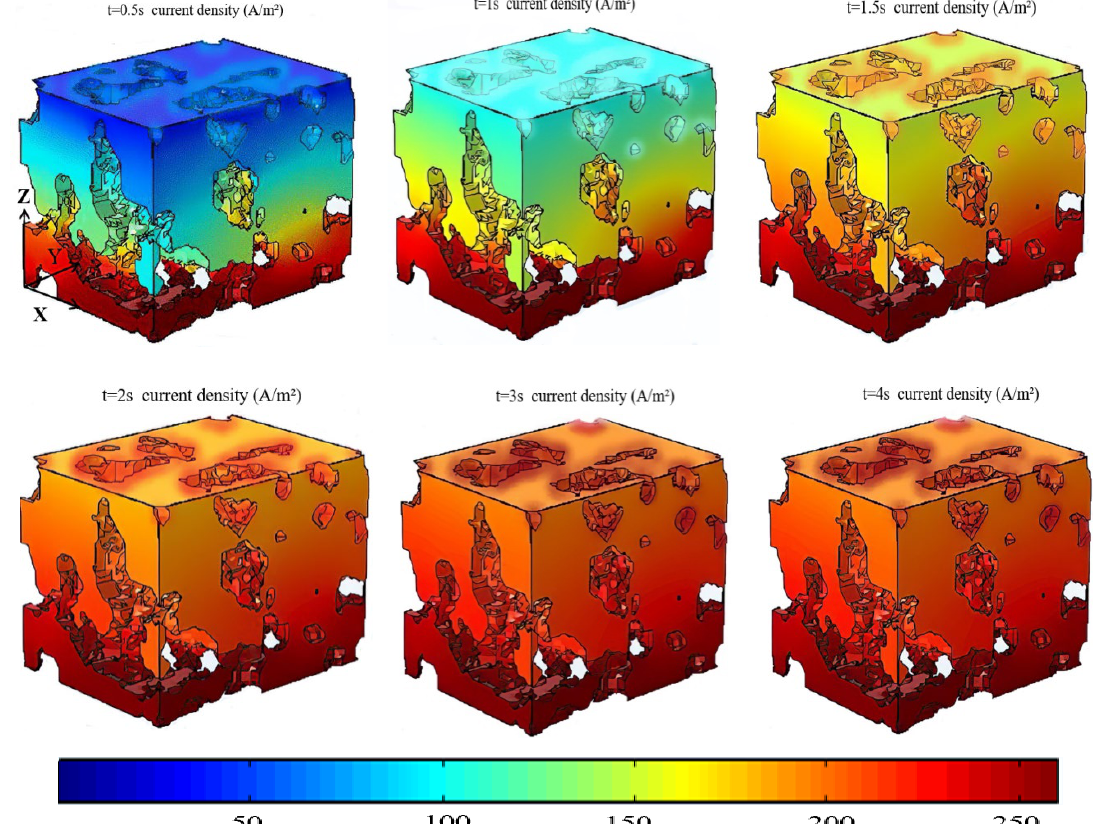
Figure 6. Distribution of current density in CL at different moments.